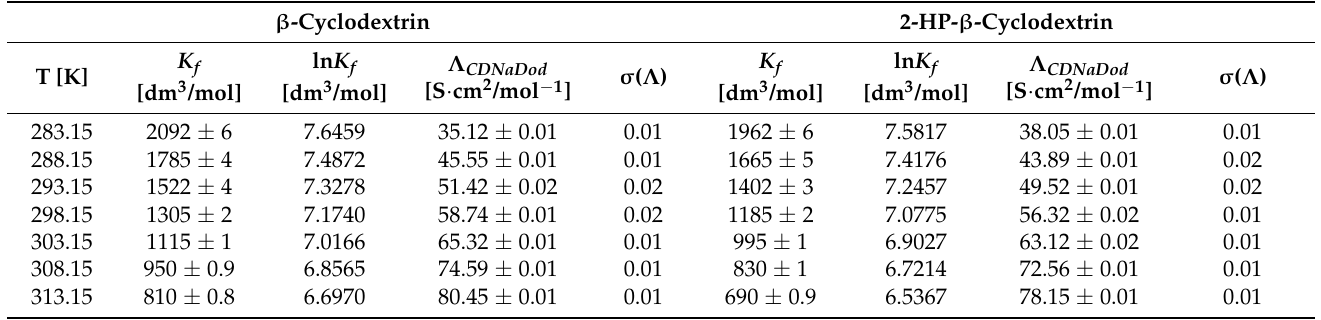
Table 3. The value of constant formation K f [dm 3 /mol], theoretical conductivity Λ CDNaDod [S · cm 2 /mol − 1 ] for β -cyclodextrin and 2-HP- β -cyclodextrin with the salt of trans -caffeic acid.